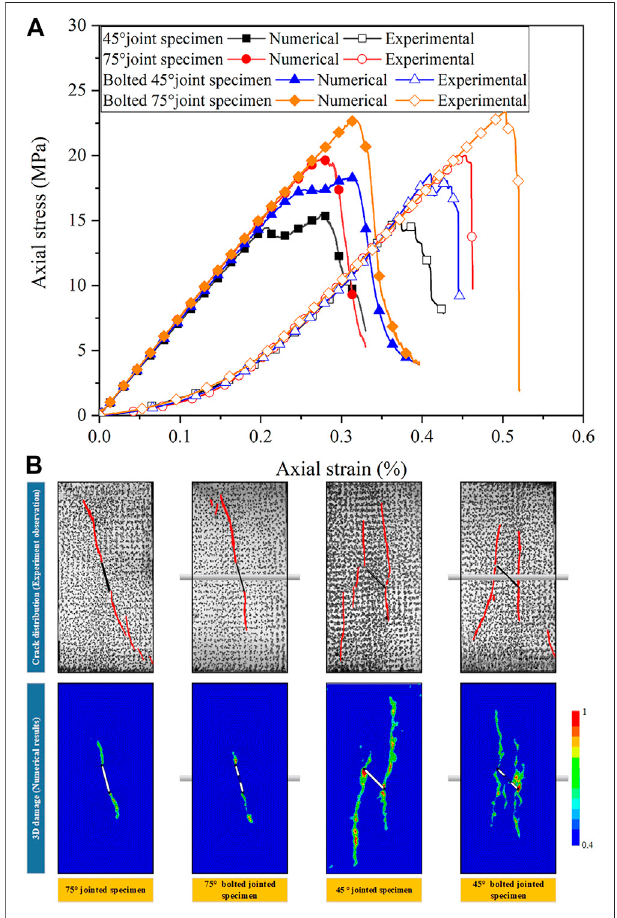
FIGURE 10 | Stress – strain curves (A) and failure modes (B) of jointed and bolted jointed specimens under uniaxial compression (experimental and